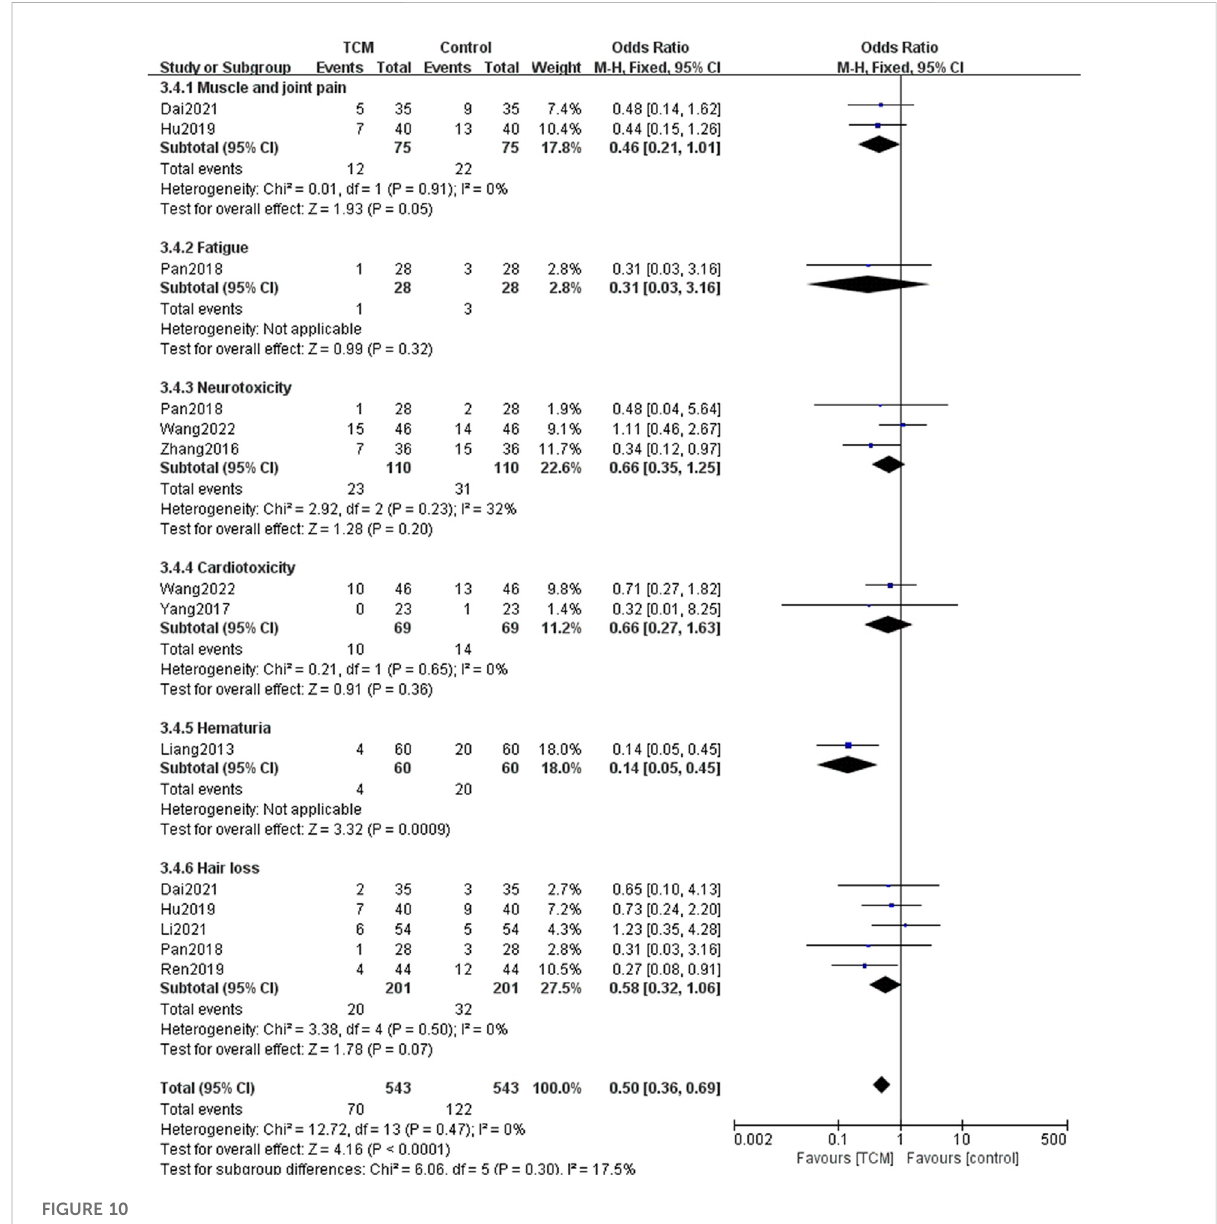
FIGURE 10 Forest plots and subgroup analysis for other adverse